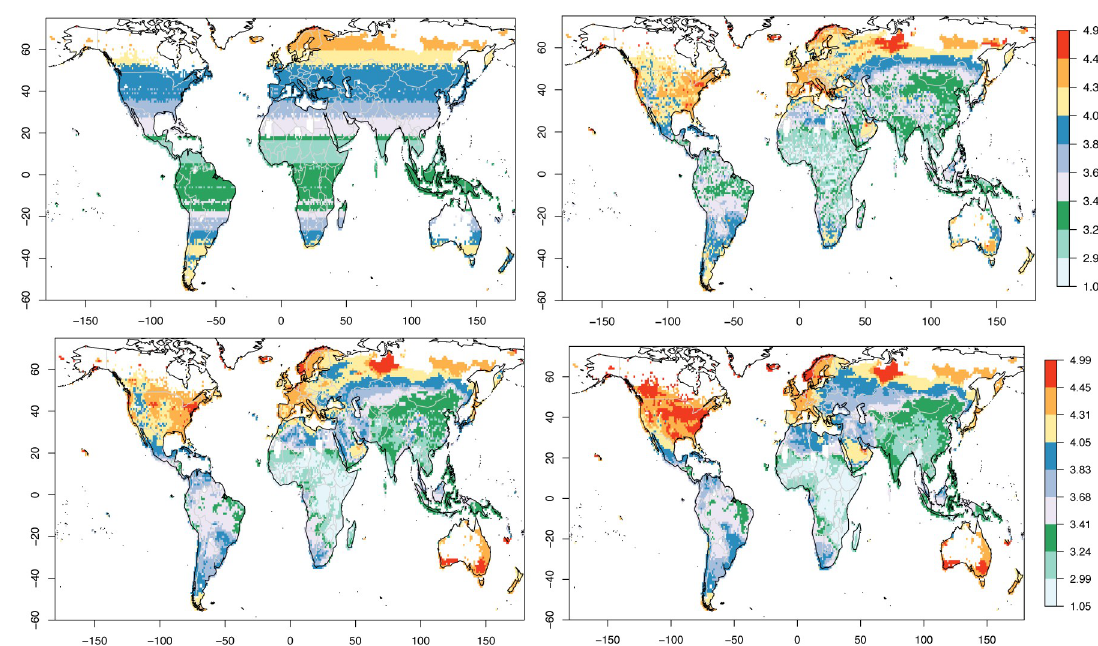
Fig 4. Maps of GCP-PC prediction. GCP-PC prediction (log 10 of k USD/person) for the global case using the top predictors (see Table 4). Top left: top predictor. Top right: top two predictors. Bottom left: top three predictors. Bottom right: top six predictors. Compare with the actual GCP-PC in Fig